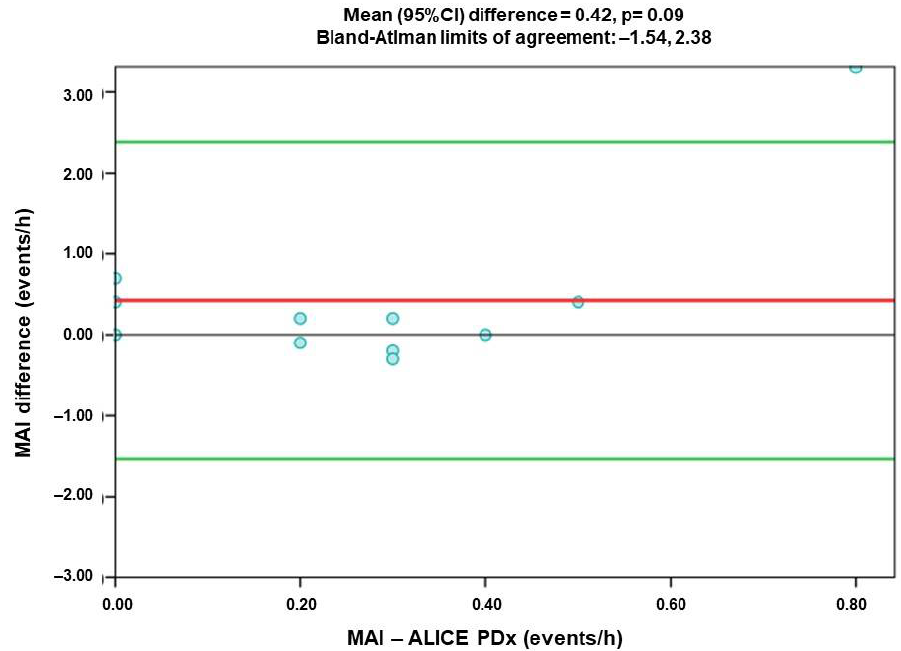
Figure 3. Bland-Altman plots. Distinction between the OAI-Alice PDx plotted against the two devices’ OAI difference ( n = 11). The red line presents the mean difference, while the green ones present the limits of agreement. OAI: obstructive apnea index.